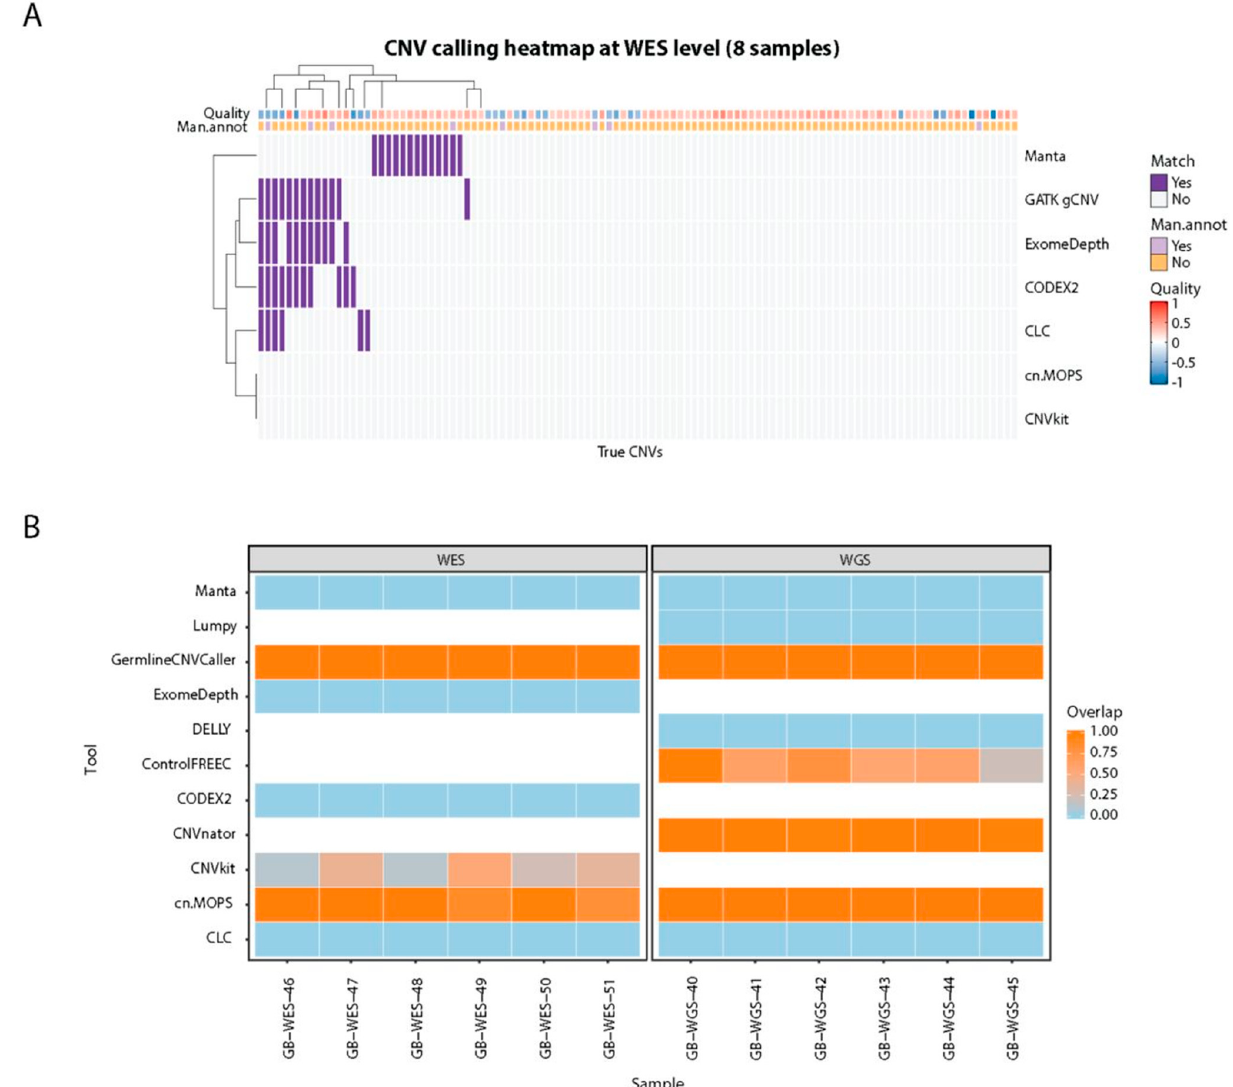
Figure 6. ( A ) CNV calling heatmap for 7 tools and 107 true CNVs at whole exome sequencing level in 8 samples (GB01-08). The Quality annotation represents the probe median score from CytoScan HD SNP-array and the Man.annot. refers to whether the CNV was independently manually confirmed. A positive quality score corresponds to duplications, and negative scores denote deletions. The order of rows/columns was determined using complete-linkage hierarchical clustering with Euclidean distance. ( B ) MLPA-confirmed CNV calling results for 11 CNV calling tools. GATK gCNV is labeled as GermlineCNVCaller.